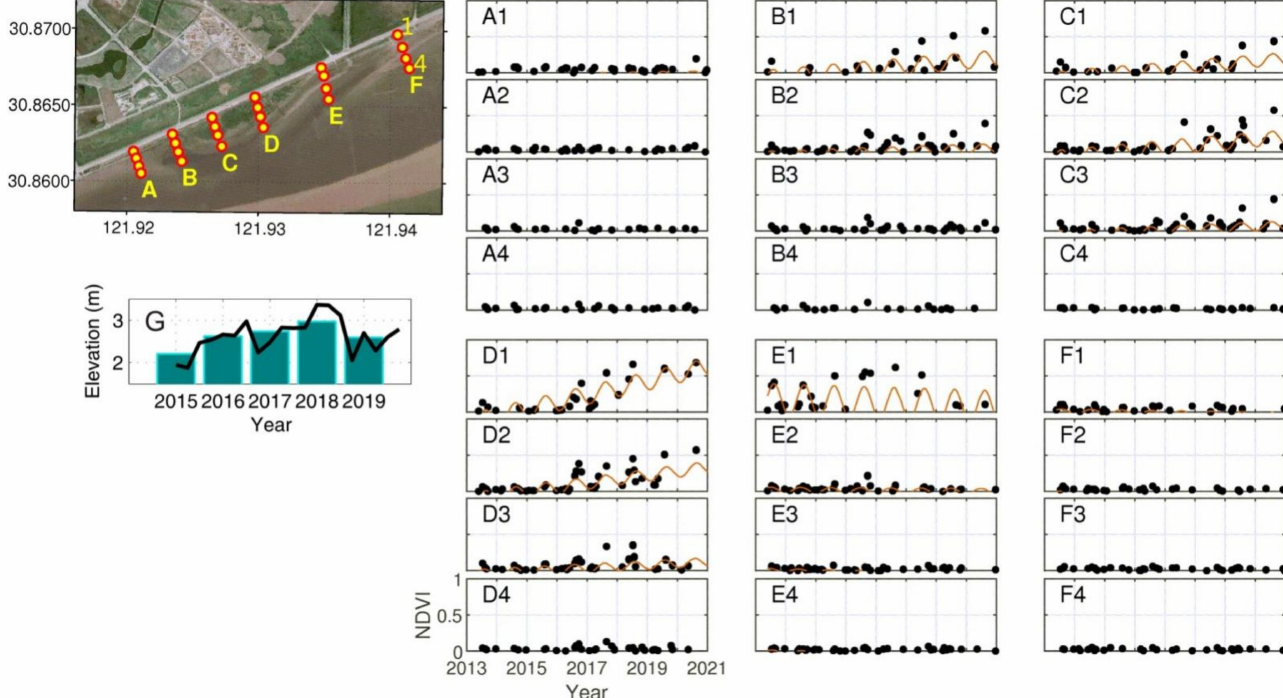
Figure 14. ( A1 – F4 ) The temporal variations in the NDVI from 2013 to 2020. The black points represent the monitored NDVI from the satellite images, and the red lines are the harmonic modeled data. ( G ) The elevation variations of point ( D3 ), black lines represent the topography derived from the reconstructed DEMs, gray bars are the annual average elevations of ( D3 ).